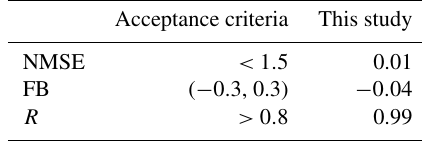
Table 2. Static values of the turbulence flow